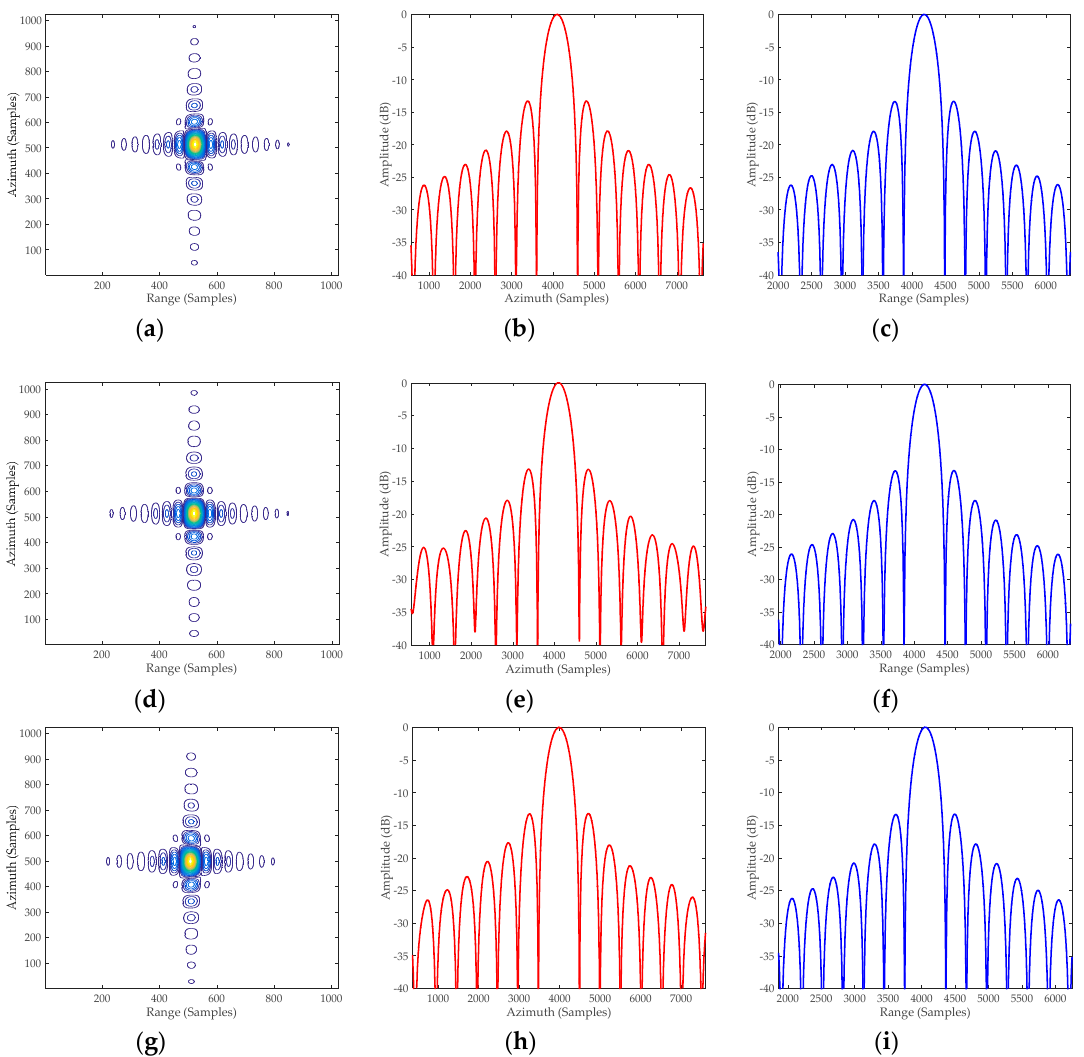
Figure 17. Imaging results of the proposed squint mode algorithm. Images ( a – i ) are equivalent representations to those given in Figure 16. Table 3. Evaluation of imaging quality (in position A).